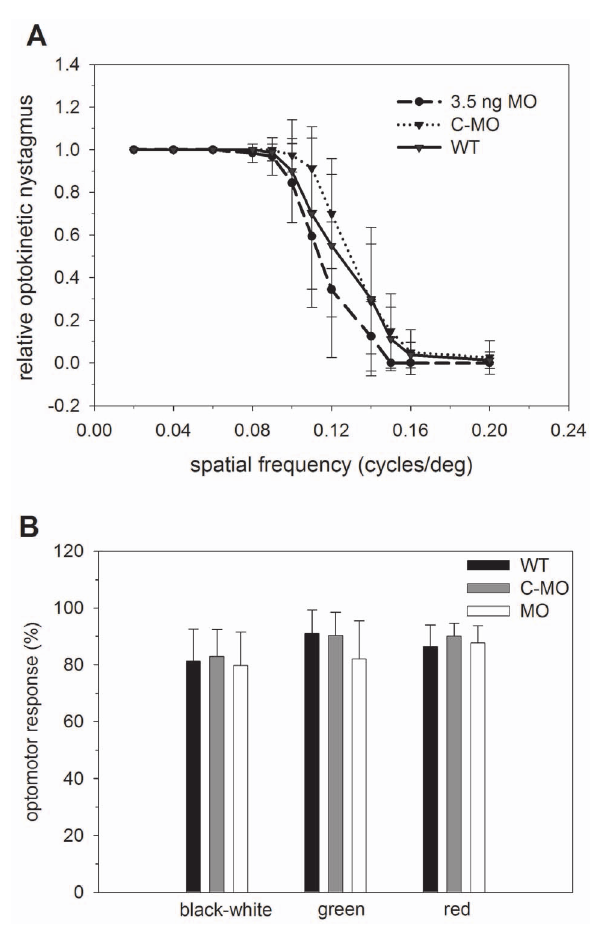
Figure 7. V isual behavioral assays. (A) Optokinetic response measurements of WT, MO and control MO larvae: 8–10 larvae at 5 dpf were investigated by presenting stimuli of a pattern of black and white stripes as described in the Methods. Results of black and green, black and red, and black and blue striped pattern are shown in supplementary Fig. S1. The relative optokinetic nystagmus is shown as a function of the spatial frequency (mean 6 s.d.). (B) Optomotor response evaluation of larvae as indicated at 6 dpf. For the black and white stimulus the mean 6 s.d. of 52 measurements is shown (MO versus WT: t =0.98, P $ 0.05; MO versus control MO: t =2.0, P =0.05; control MO versus WT: t =1.05, P $ 0.05), for the coloured stimuli the mean 6 s.d. of 12 data sets each is shown (black/green MO versus WT: t =1.94, P $ 0.05; MO versus control MO: t =1.8, P $ 0.05; control MO versus WT: t =0.19, P $ 0.05). Black / red: MO versus WT: t =0.44, P $ 0.05; MO versus control MO: t =1.05, P $ 0.05; control MO versus WT: t =1.4, P $ 0.05).